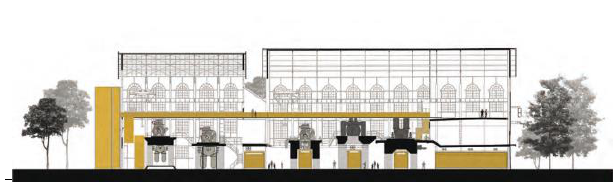
Figure 11. Energy Museum with the addition of a stairway and a viewing.